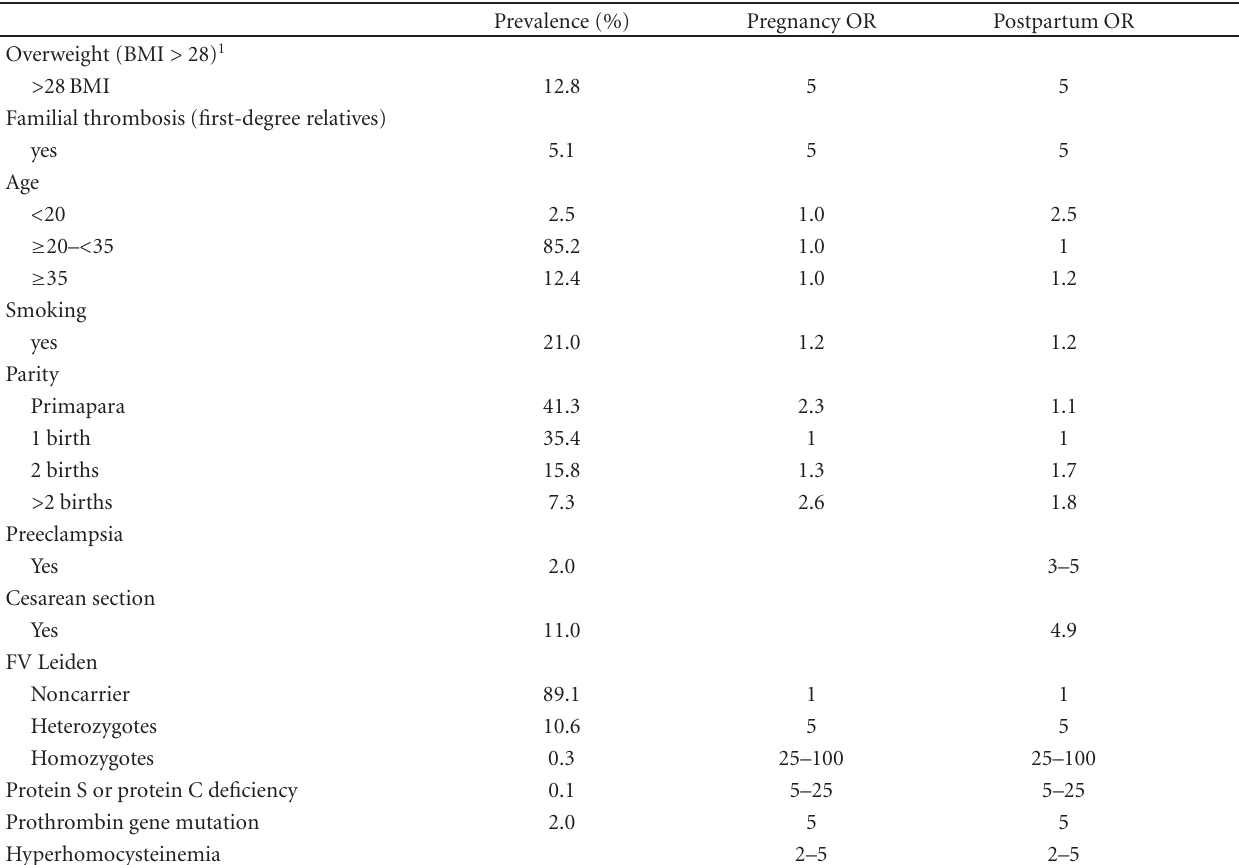
Table 1: Risk factors and their odds ratios (ORs) f¨or VTE